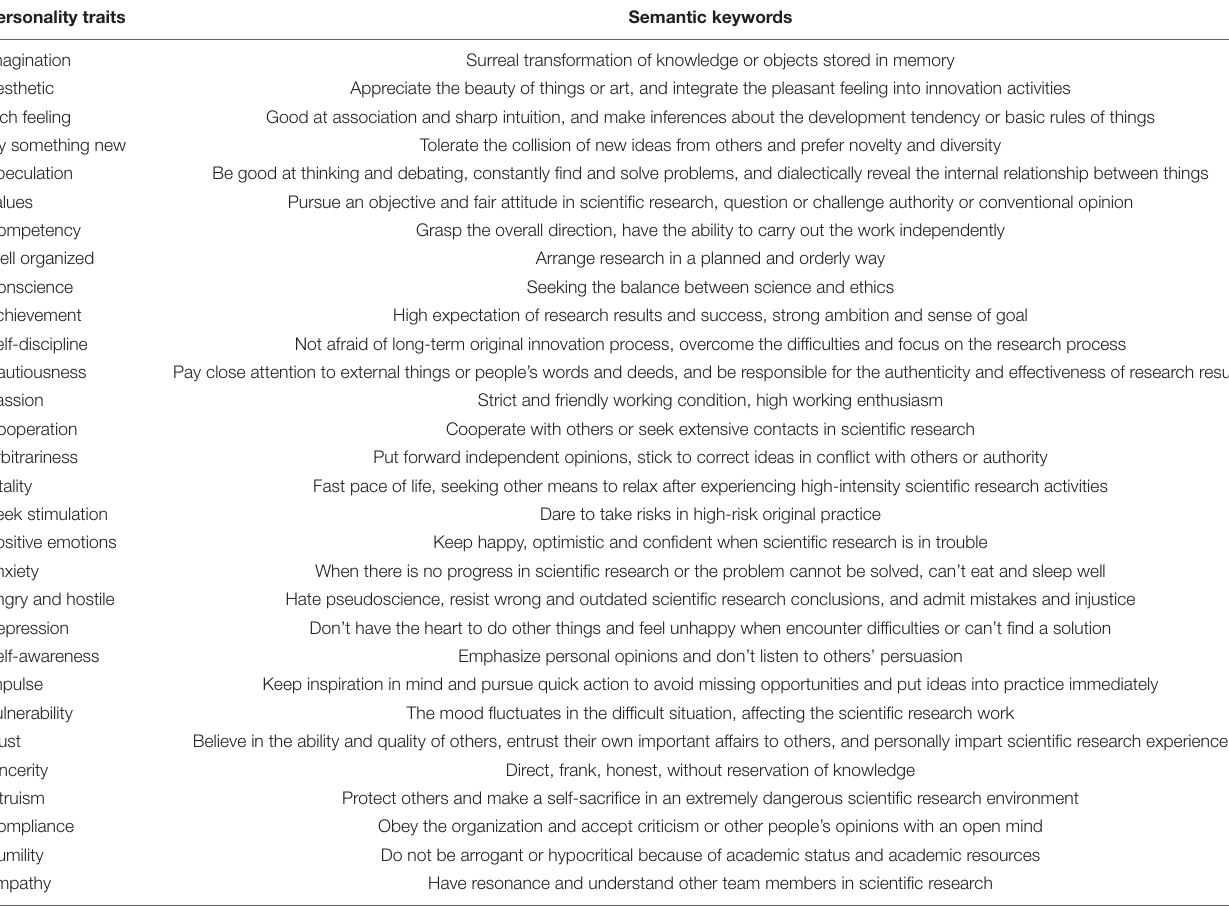
TABLE 2 | Semantic framework for the conceptual model of personality traits of original innovation talent. Personality traits